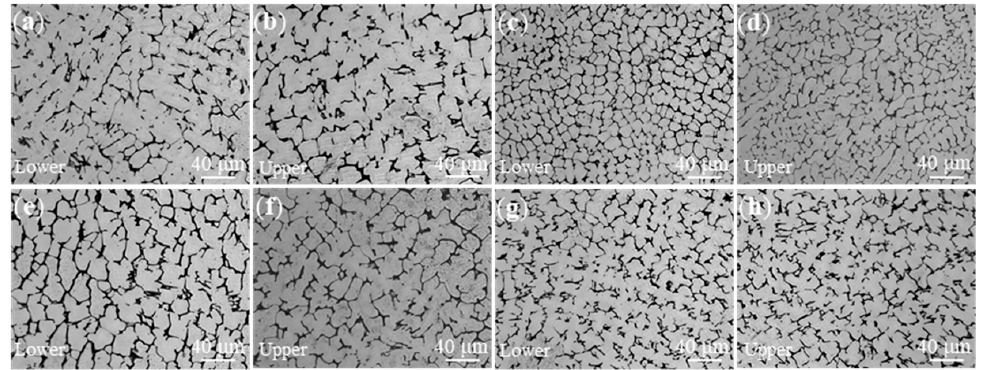
C2, ( c , d ) sample C3, ( e , f ) sample U2, ( g , h ) sample